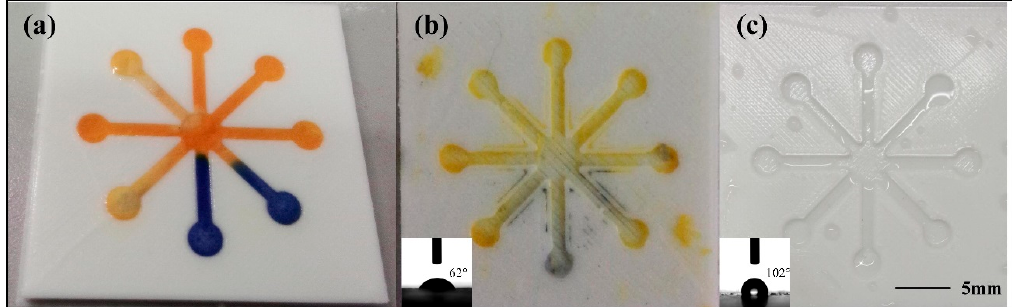
Figure 2. Comparison between the PDMS coated substrate and uncoated substrate: ( a ) PH test on the fabricated microfluidic device; ( b ) PDMS uncoated substrate washed by water after PH test (inset: water contact angle image of PDMS uncoated substrate); ( c ) PDMS coated substrate washed by water after PH test (inset: water contact angle image of PDMS coated substrate).